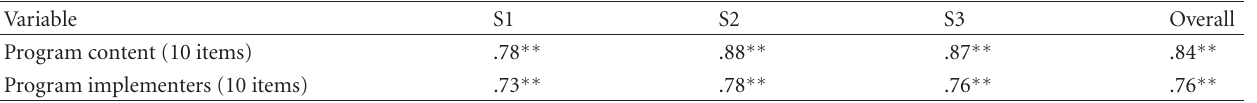
Table 6: Correlation coe ffi cients on the relationship between program components and program e ff ectiveness. Variable S1 S2 S3 Overall